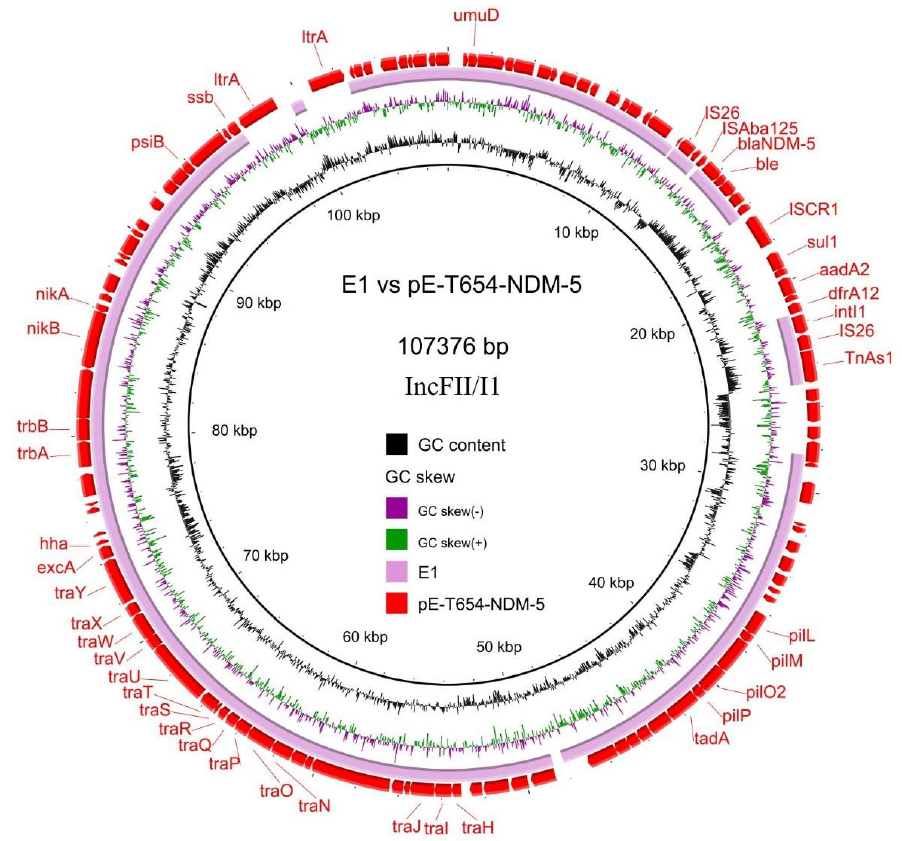
Figure 3. Circular alignments of the reference plasmid sequence (pE − T654 − NDM − 5, GenBank ac-